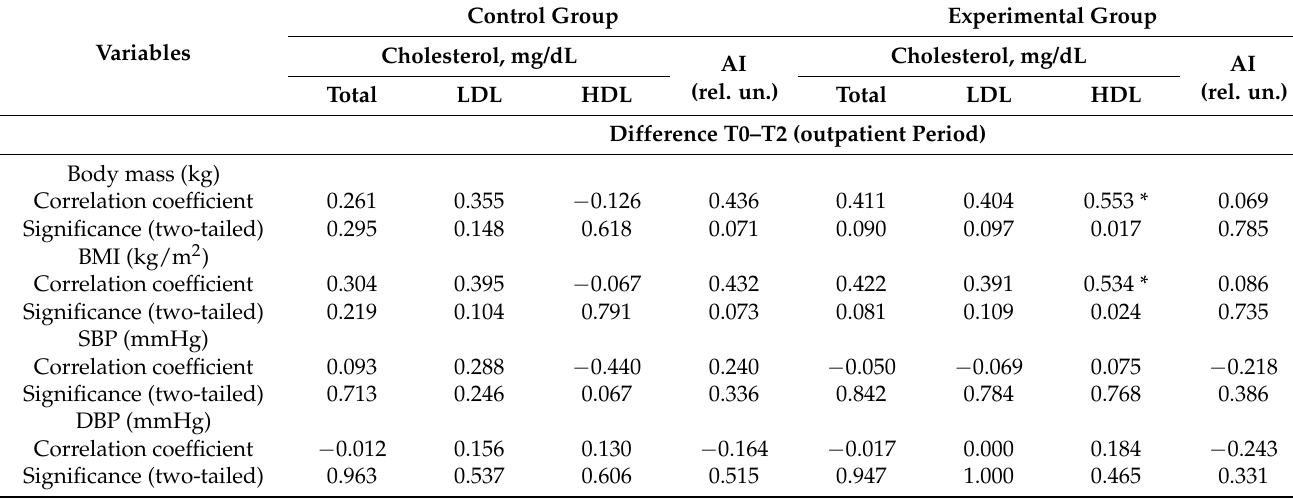
Table 6. Correlation between patient serum cholesterol profile and anthropometry and blood pressure during the trial. Control Group Experimental Group Variables Cholesterol, mg/dL (rel. un.)